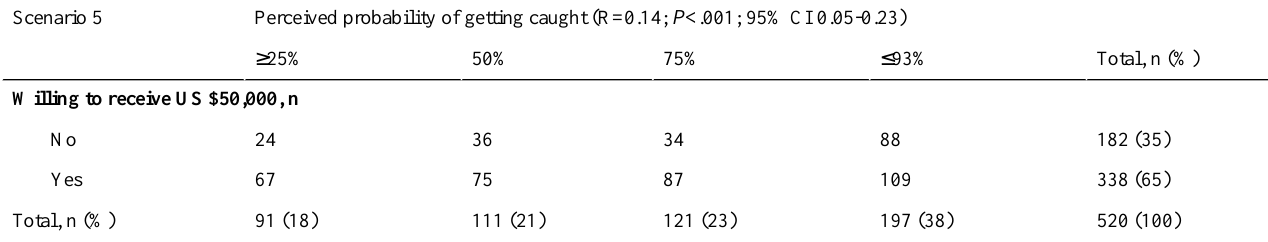
Table 5. Personal context: best friend needs air medical transportation (scenario